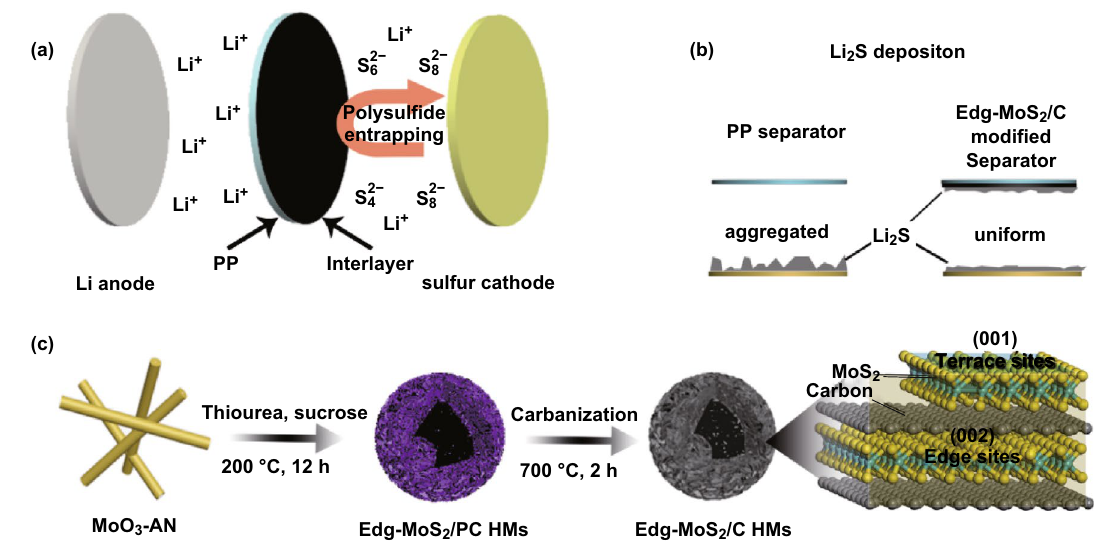
Fig. 1 Schematic illustration of the synthesis and application of the Edg‑MoS 2 /C@PP separators in Li–S batteries. a Schematic of polysulfides entrapped in the Li–S battery using the Edg‑MoS 2 /C@PP separator. b Schematic of Li 2 S deposition in the Edg‑MoS 2 /C@PP and PP cells. c Synthesis route of the Edg‑MoS 2 /C HMs and schematic of the edge and terrace sites of the Edg‑MoS 2 /C